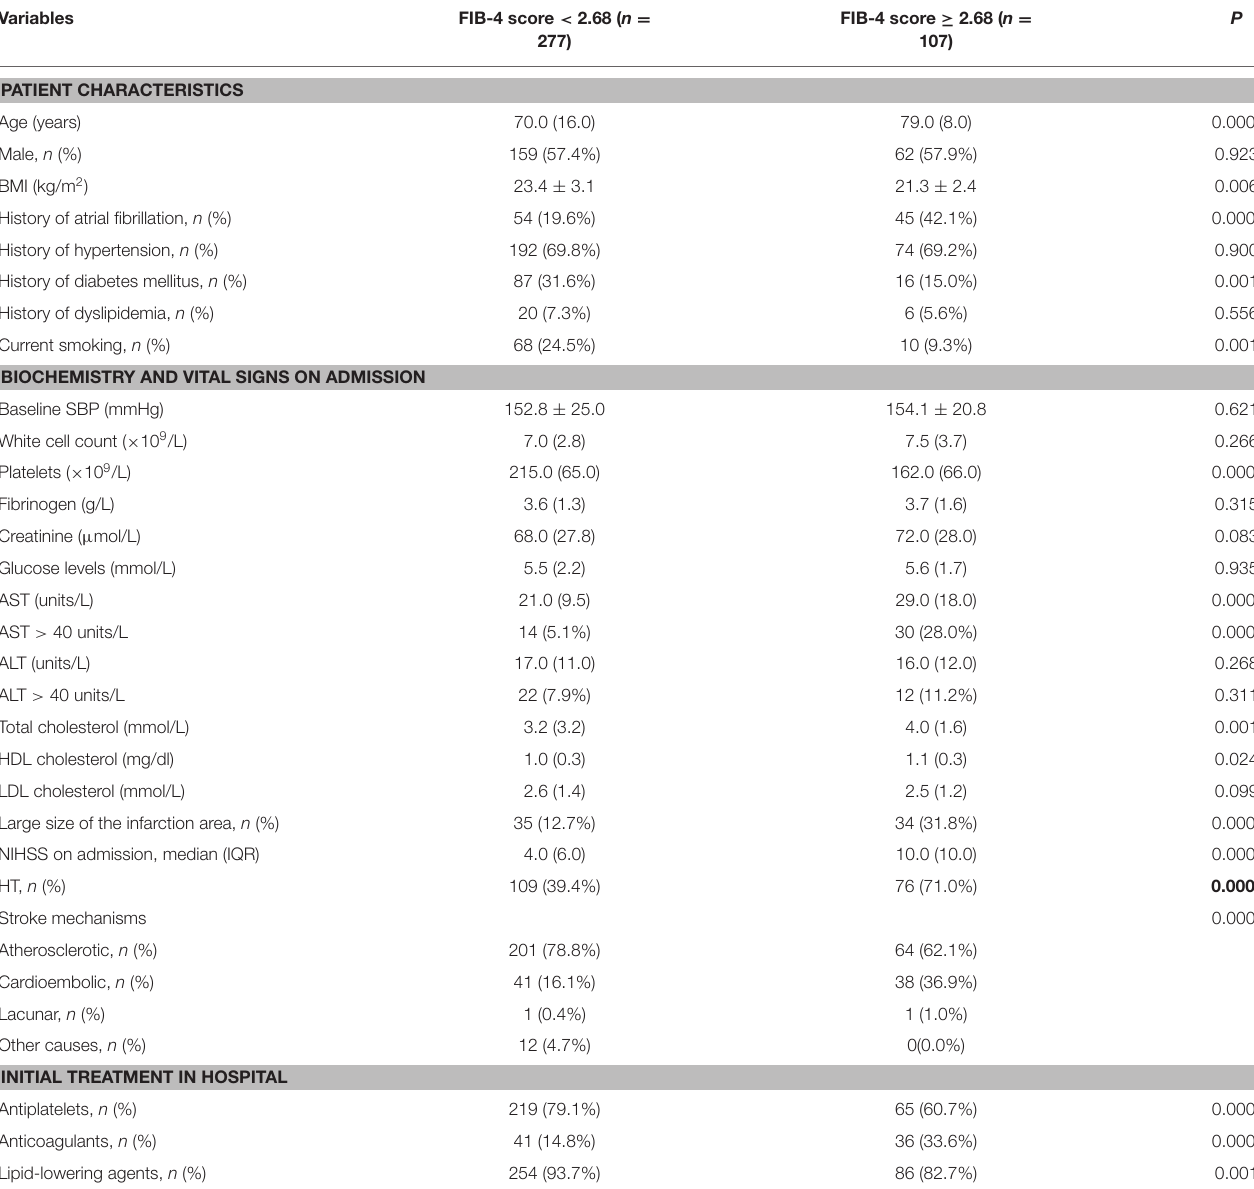
TABLE 2 | Baseline characteristics of patients with AIS, stratified by FIB-4 scores of < 2.68 and ≥ 2.68.